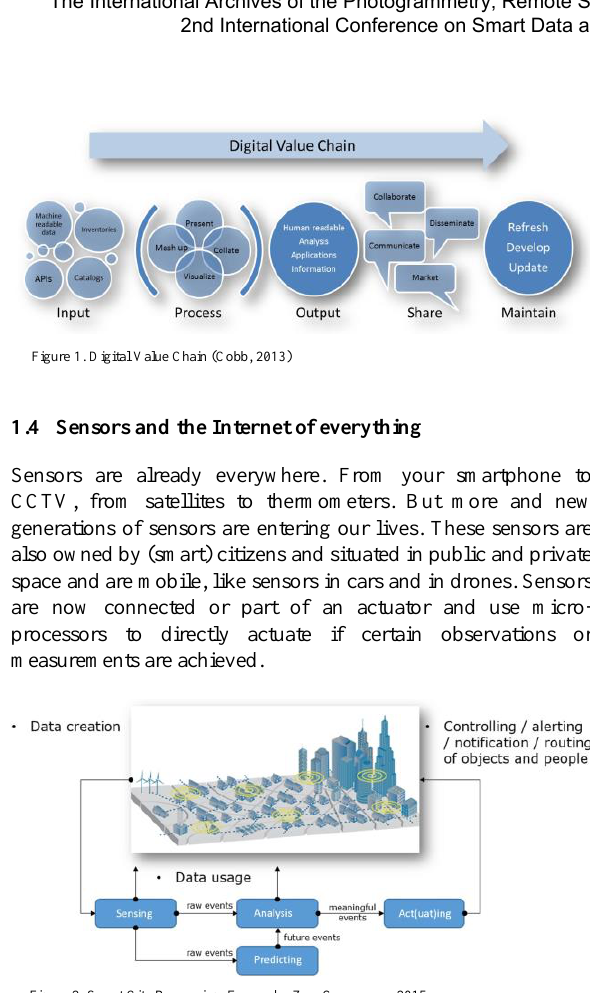
Figure 2. Smart City Processing; E. van der Zee, Geonovum, 2015